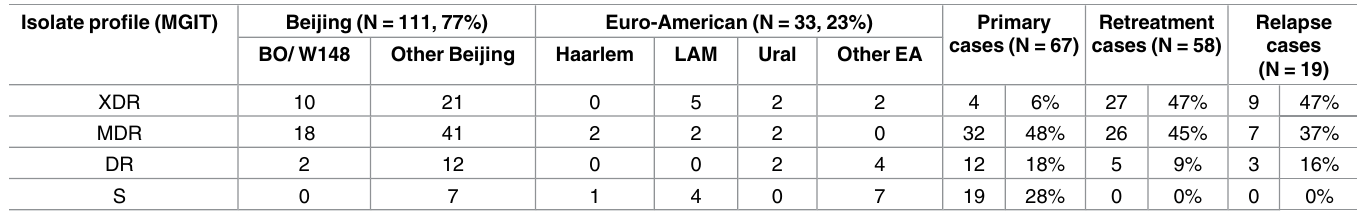
Table 3. Associations of the drug resistance profile with the strain lineage and the patient history of previous anti-TB drugs. Isolate profile